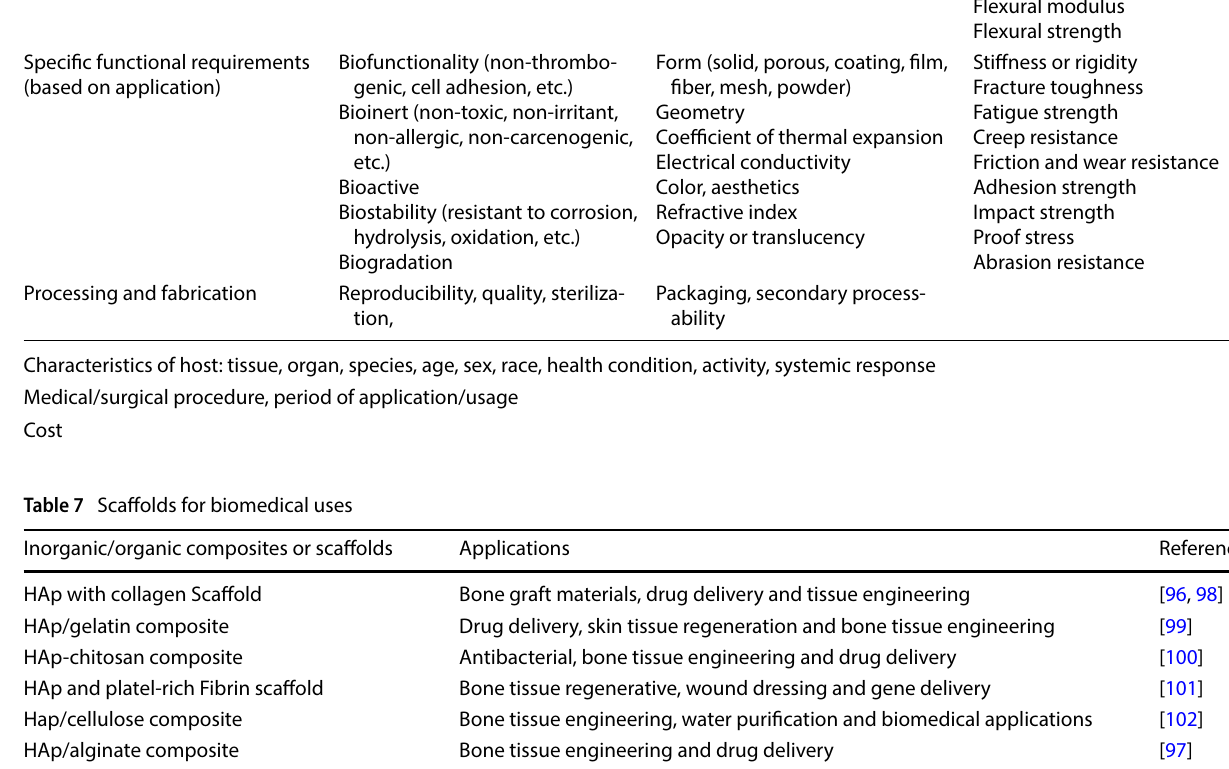
Table 6 Considerations for materials selection [104]